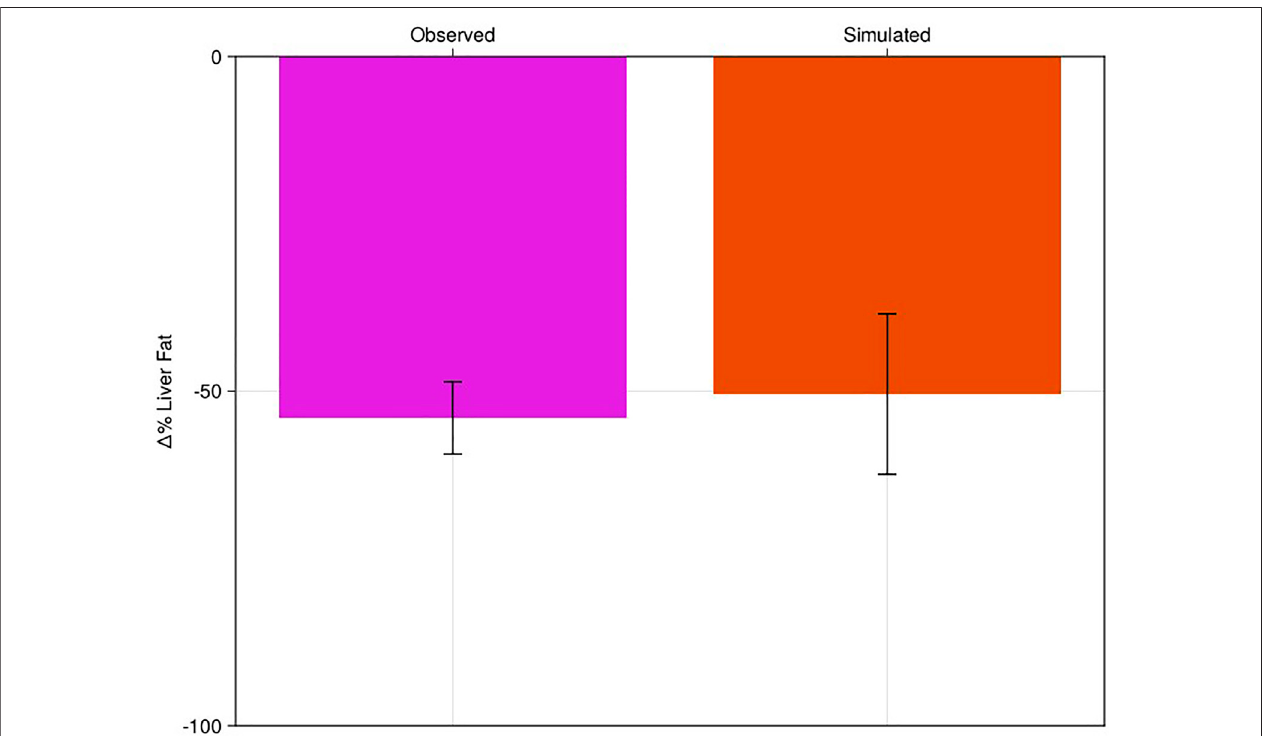
FIGURE 3 | Percent change in liver fat of virtual population to pioglitazone-like therapy with comparison to literature. Clinical results of Belfort et al. (pink bar) compared to the NAFLD virtual patient response to pioglitazone (red). Bars are mean response of the cohort or virtual patients; error bars are estimated standard